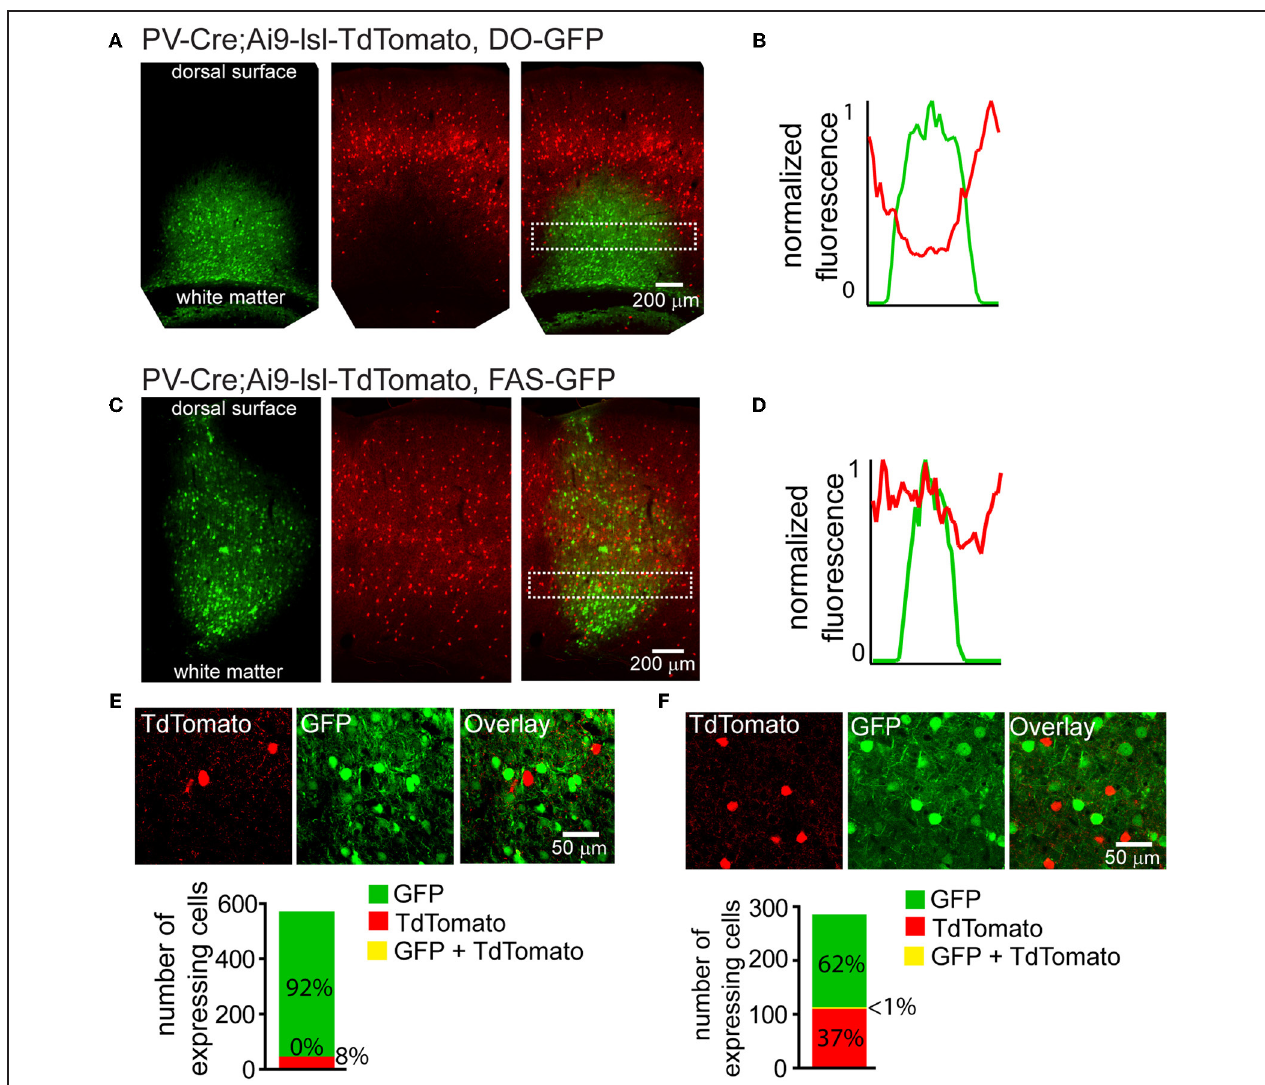
FIGURE 5 | Cre-Off infection with DO rAAV interferes with the expression of fluorescent Cre reporter allele whereas infection with FAS rAAV does not. (A) Coronal section through the cortex of PV-Cre; Ai9-lsl-TdTomato mouse after infection with DO-GFP. Separate GFP and TdTomato fluorescent channels demonstrate that Cre reporter fluorescence is drastically reduced in the area of DO-GFP infection. (B) Normalized mean fluorescent values for GFP and TdTomato quantified from boxed inset in A . (C) Coronal section through the cortex of PV-Cre; Ai9-lsl-TdTomato mouse after infection with FAS-GFP. Separate GFP and TdTomato fluorescent channels demonstrate that Cre reporter fluorescence is not reduced in the area of FAS-GFP infection. (D) Normalized mean fluorescent values for GFP and TdTomato quantified from boxed inset in C . (E) DO-GFP expression is